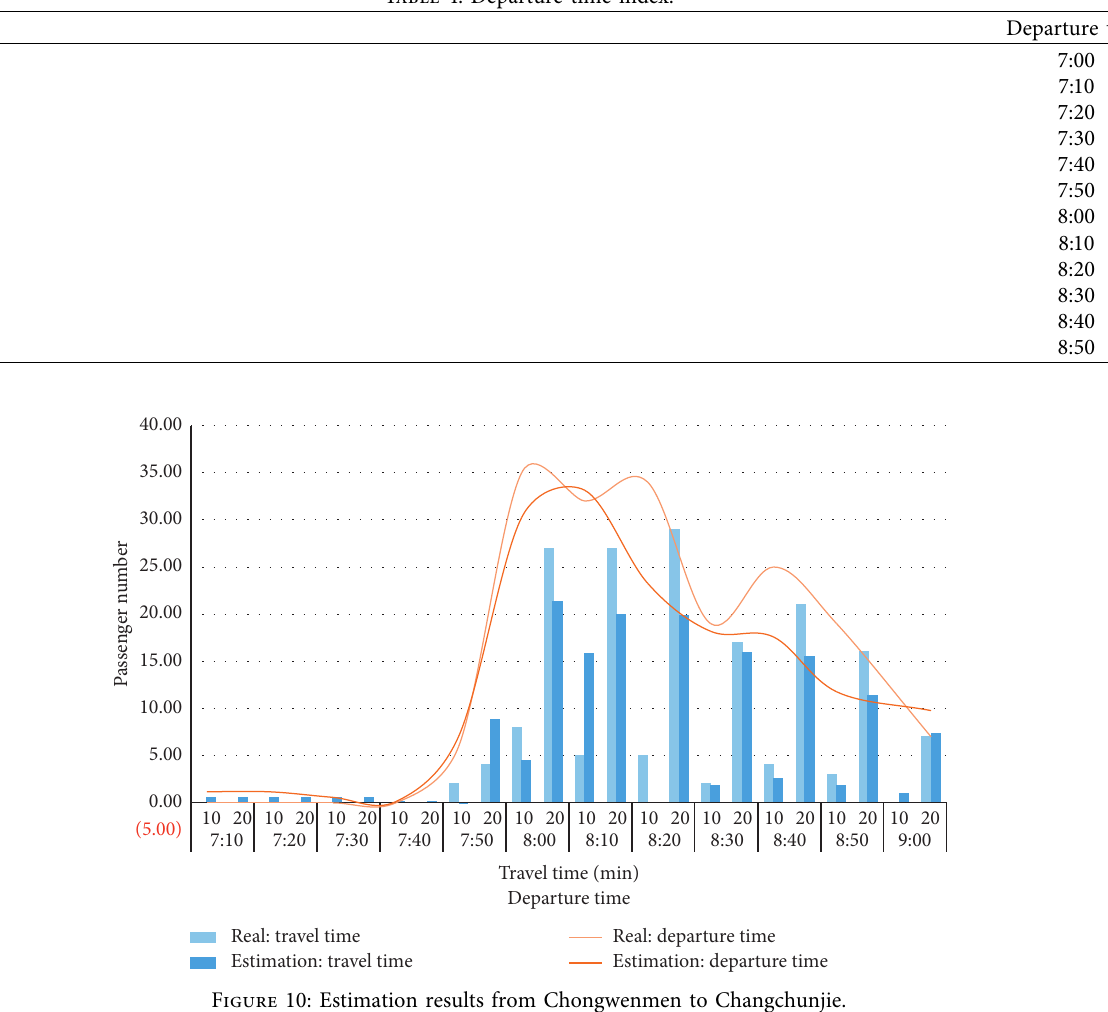
Figure 9: RMSN from Chongwenmen Station. (a) Three-dimensional surface graph of RMSN. (b) Contour graph of RMSN. Table 4: Departure time index.